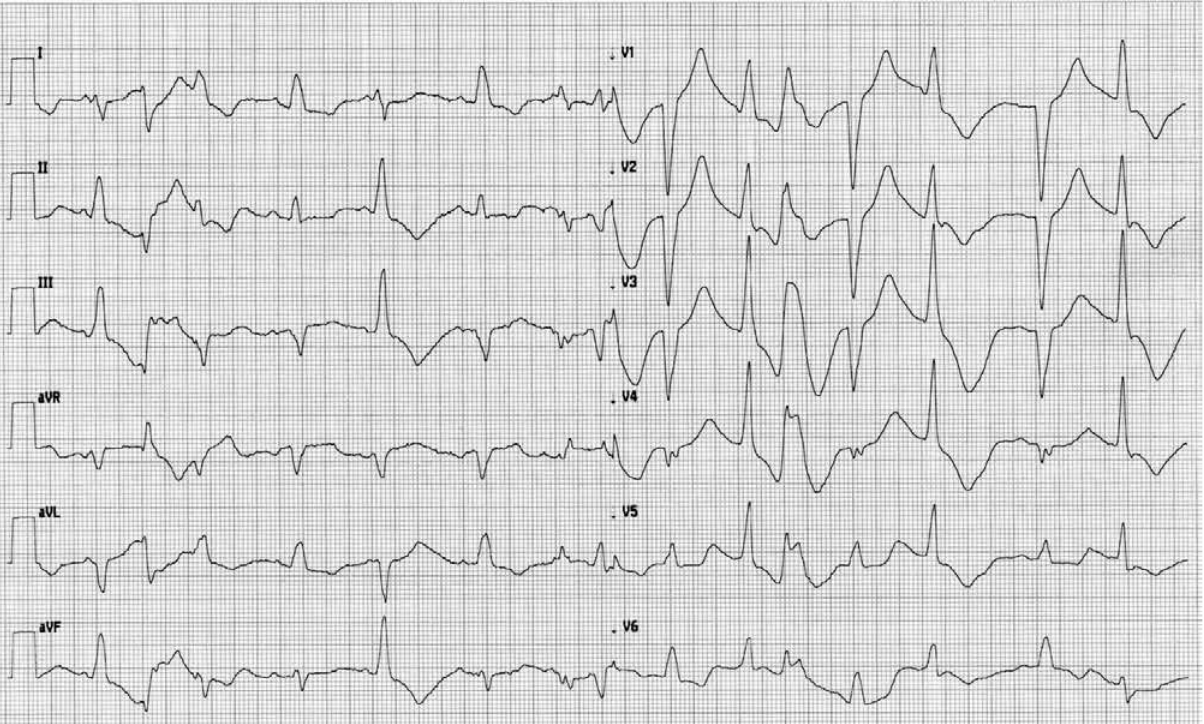
Figure 4: Follow-up ECG. Noticeable ventricular arrhythmia (ventricular pairs) just after switching-off of resynchroni- zing